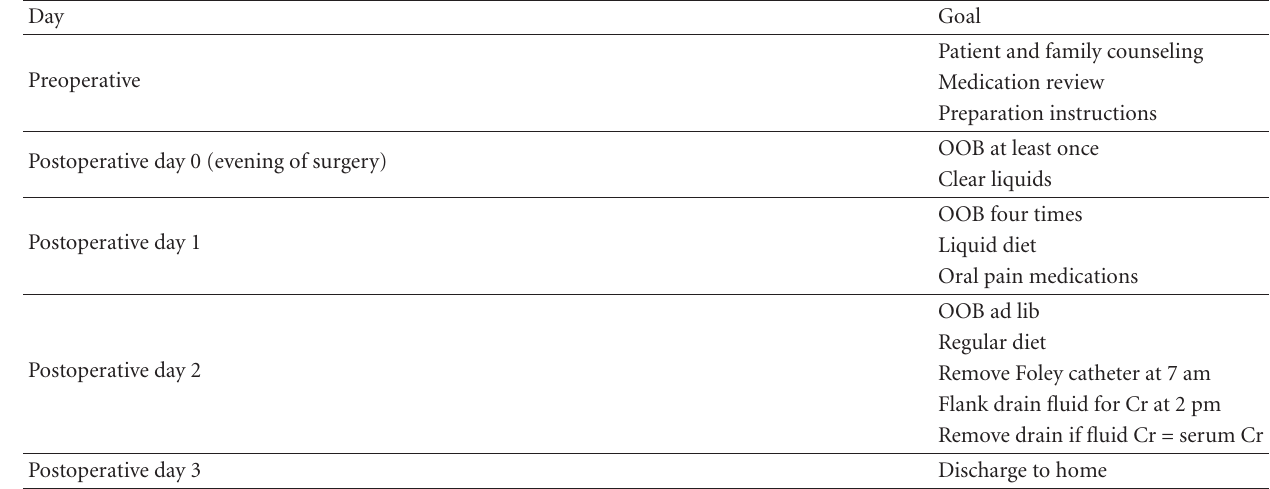
Table 1: Fast track